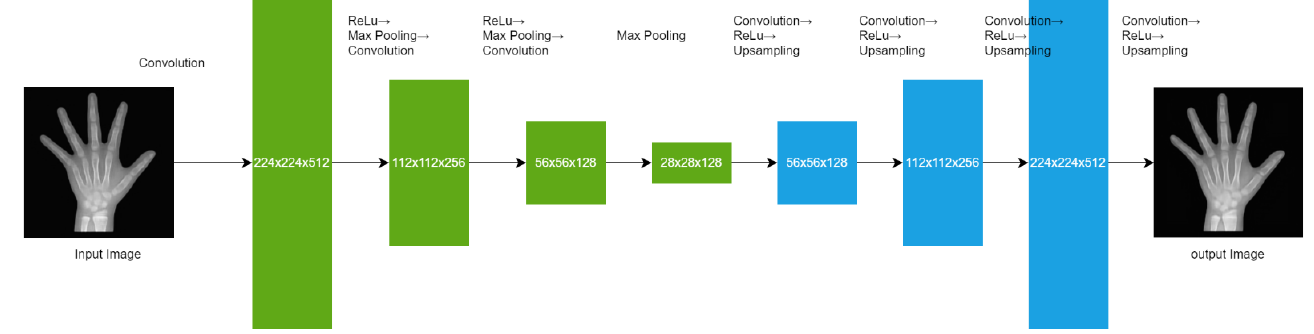
Figure 3. The architecture of CNN - based autoencoder.